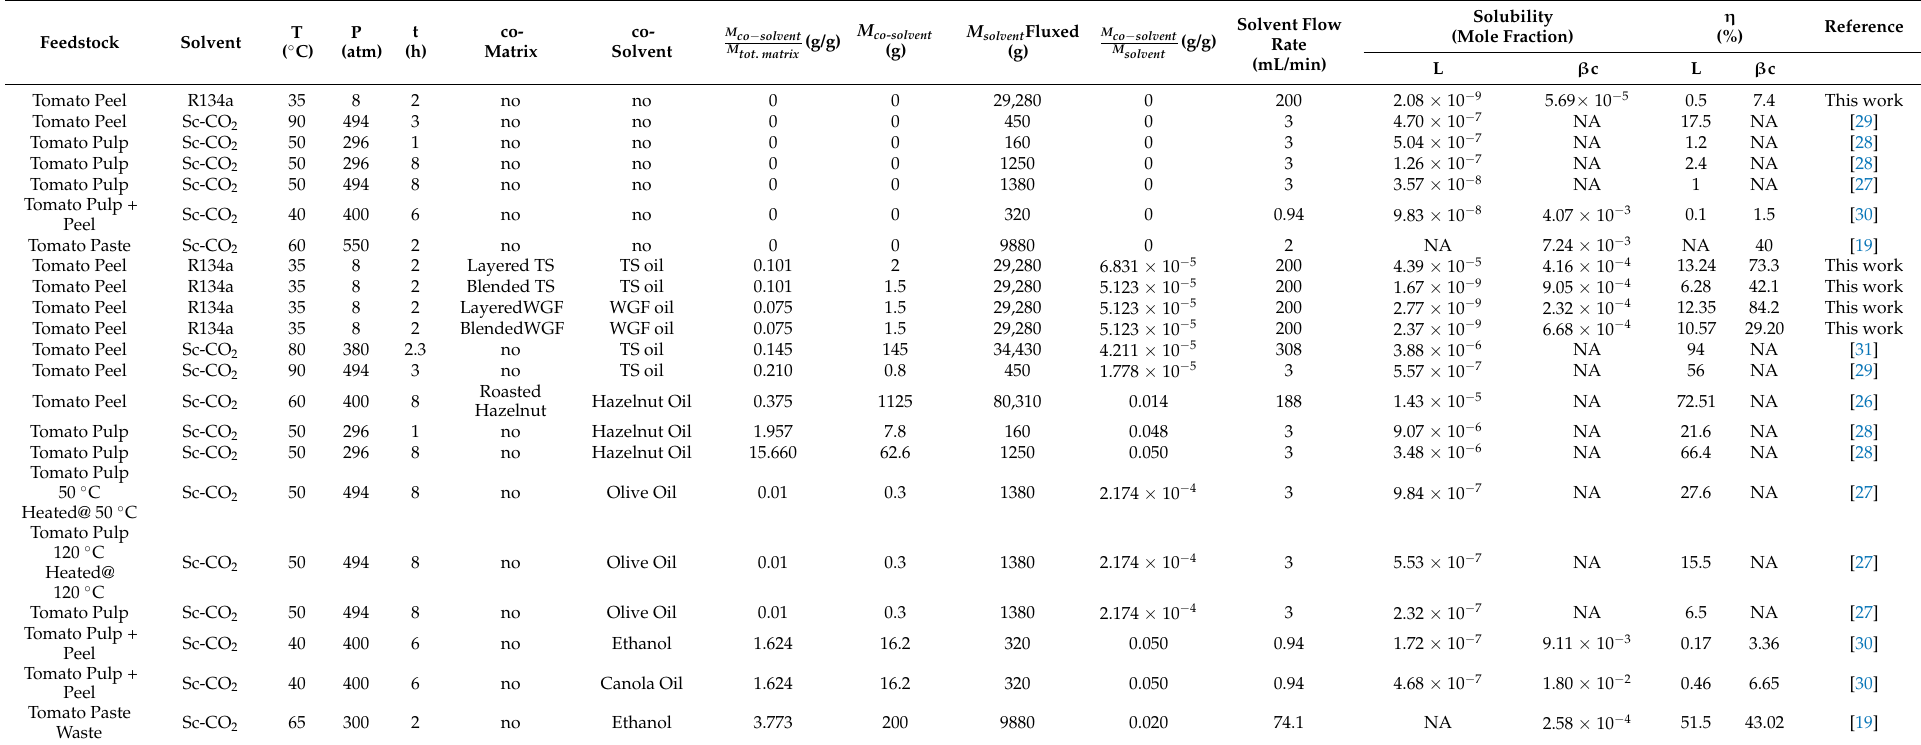
Table 6. Summary of the main operating conditions used for extracting lycopene (L) and β -carotene ( β c) from tomato pomace using sc-CO 2 or Norflurane (R134a) with or without presence of co-solvents; extraction yields ( η ), and effective solubilities in eventual oily co-solvents used. TS: tomato seeds; WGF: wheat germ